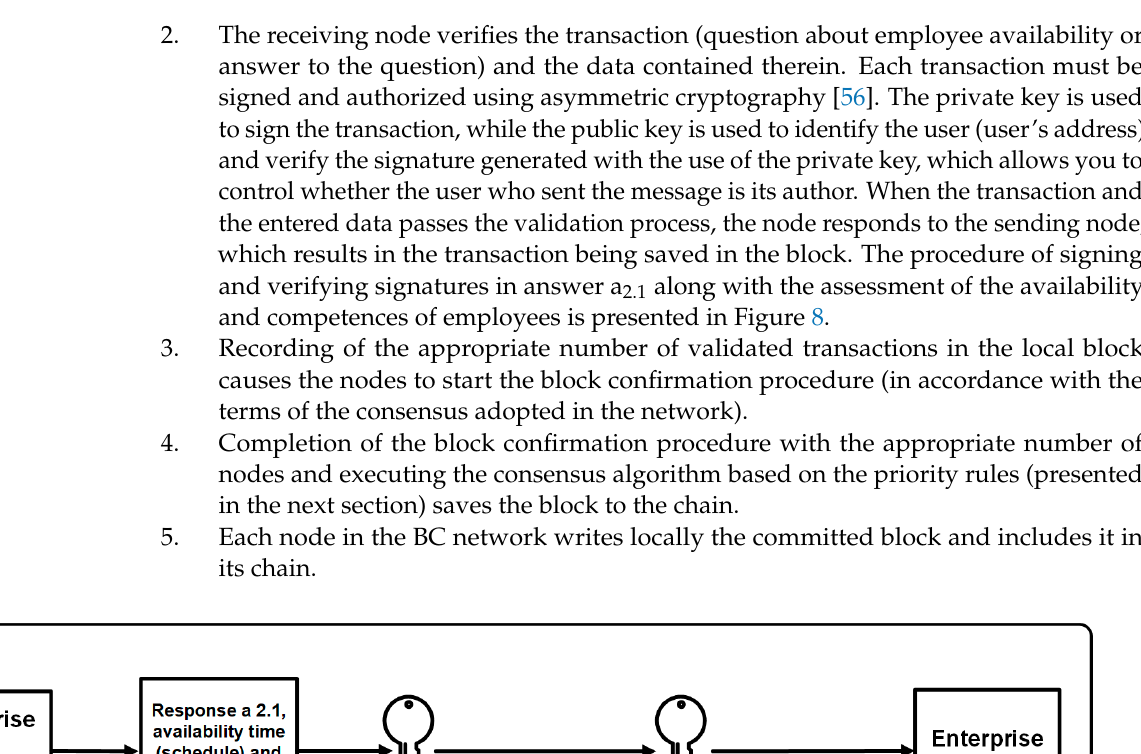
9 of 21 Figure 7. Blockchain for reacting to subsequent orders for employees and building consensus. # marks the beginning of a comment that continues to the end of the physical line. # precedes the